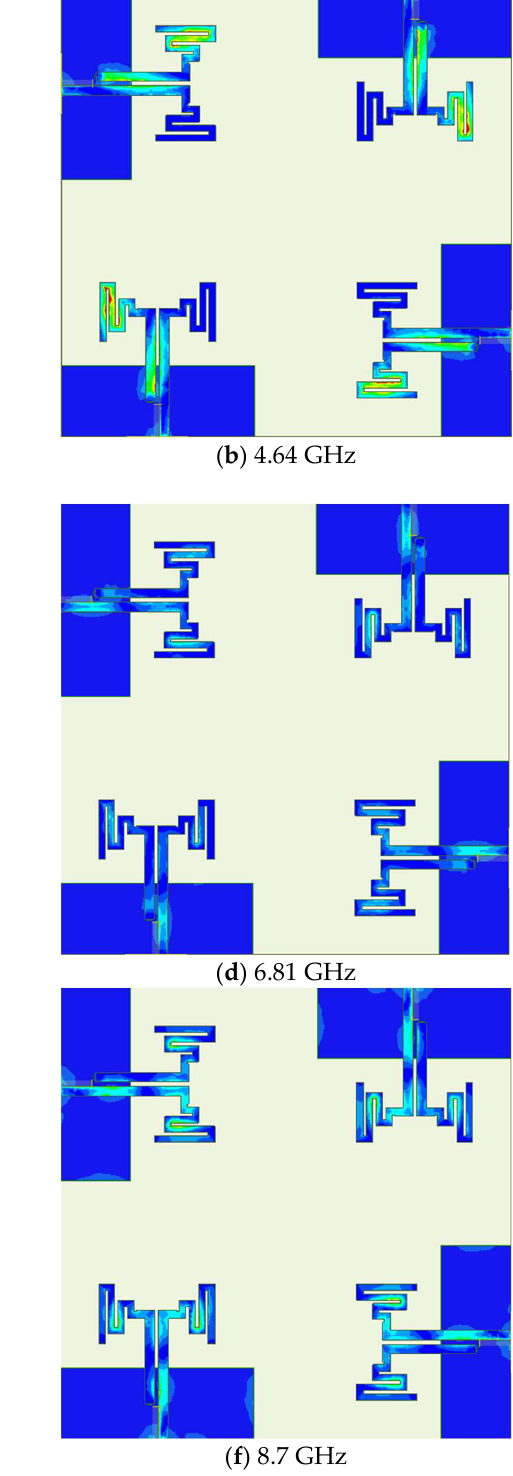
Figure 10. Current distribution at the rejection bands center frequency; ( a ) at 3.24 GHz, ( b ) at 4.64 GHz, (c) at 5.48 GHz, (d) at 6.81 GHz, (e) at 7.51 GHz, (f) at 8.7 GHz.